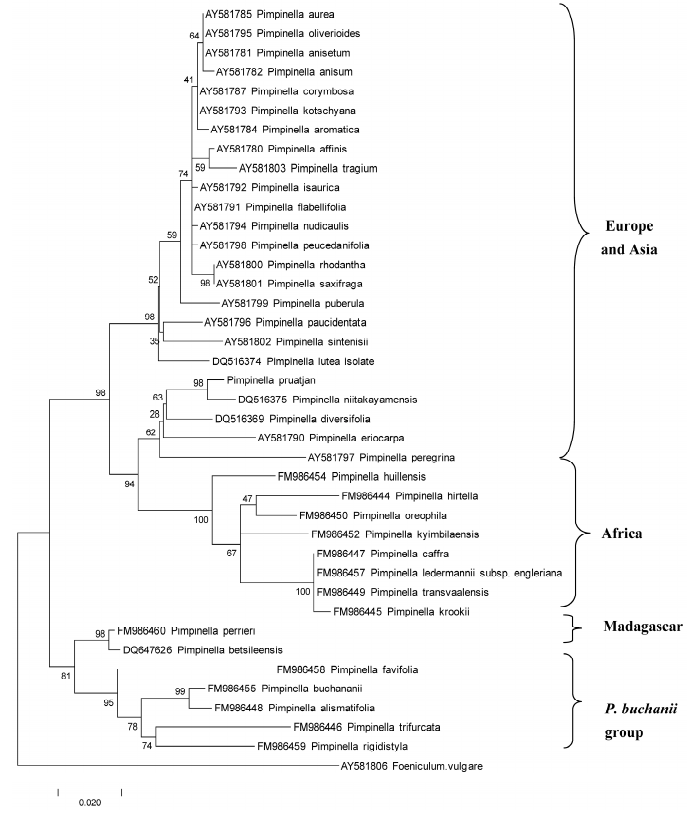
Figure 1. Molecular Phylogenetic analysis of Pimpinella pruatjan and the connection to the African species by Maximum Likelihood method. Numbers at the nodes are Bootstrap values from 500 replications.